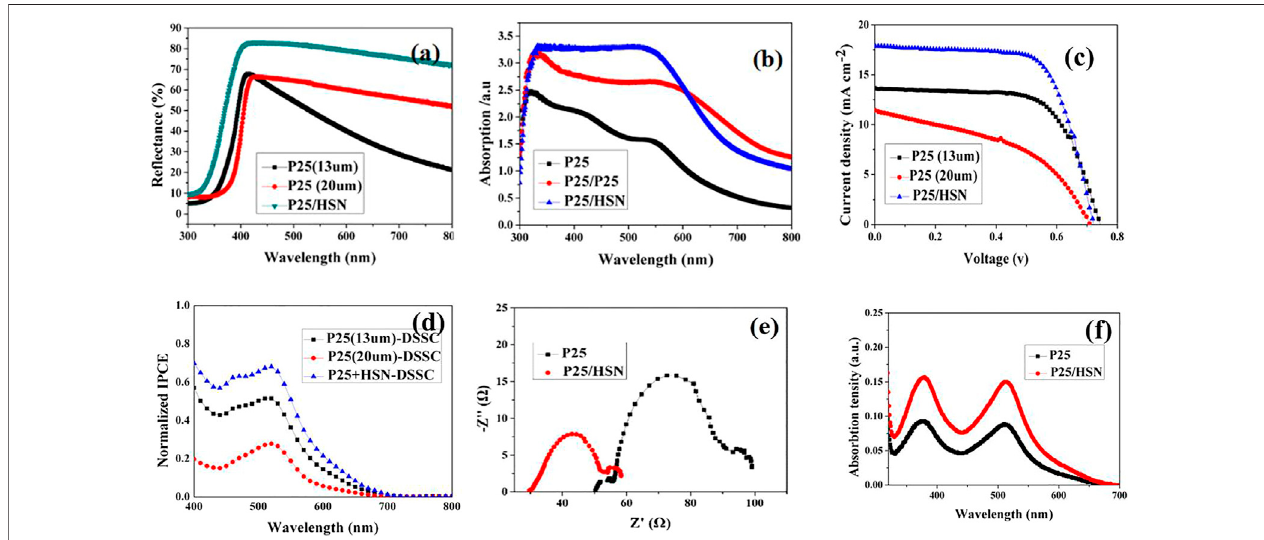
FIGURE4|(A) Diffusere fl ectancespectrabeforedyeadsorption; (B) Absorptionspectraafterthedye adsorption ofthephotoanode fi lms; (C) Current-voltage(IV) curves (D) IPCEspectraofthecellswithP25(13 μ m),P25(20 μ m)andP25/HSNelectrodesunderonesunillumination; (E) EIScurvesofP25(13 μ m)cellandP25/HSN cell; (F) The optical absorption spectra of dye loading in TiO 2 P25 (13 μ m), P25/HSN electrodes.